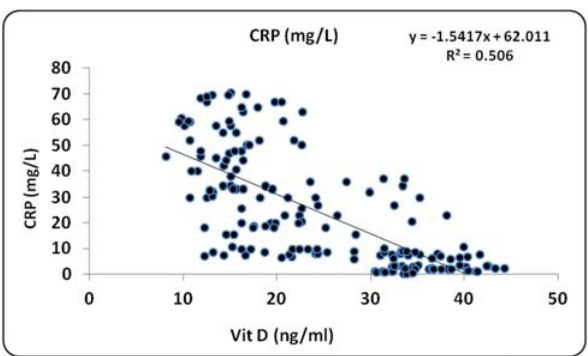
Table 3: Correlation between Vit D with TNF - alpha ( pg/mL ) , CRP (